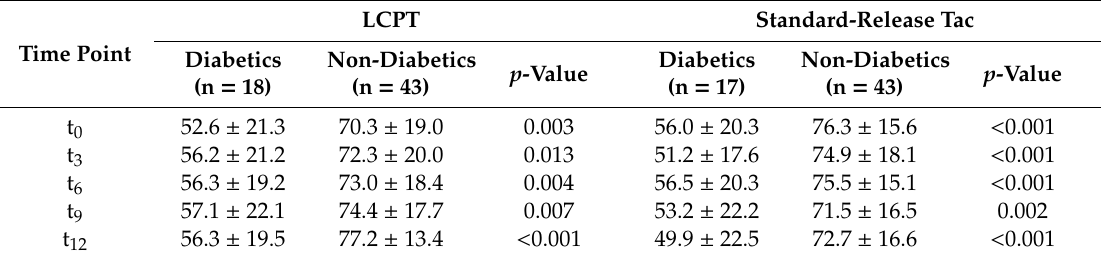
Table 5. Glomerular filtration rate (eGFR; mL / min / 1.73 m 2 ) in diabetic and nondiabetic patients.